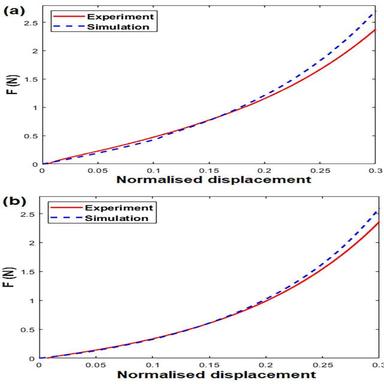
The compression force versus the normalised displacement and comparing the FE simulation results to experiments; (a) 0-degree and (b) 90-degree compression test.'